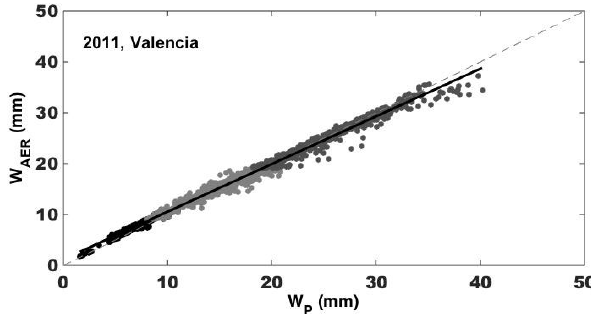
Figure 6. Scatter plot of W AER vs. W P for Valencia site; alterna- tions of black and greys indicate the three water vapour